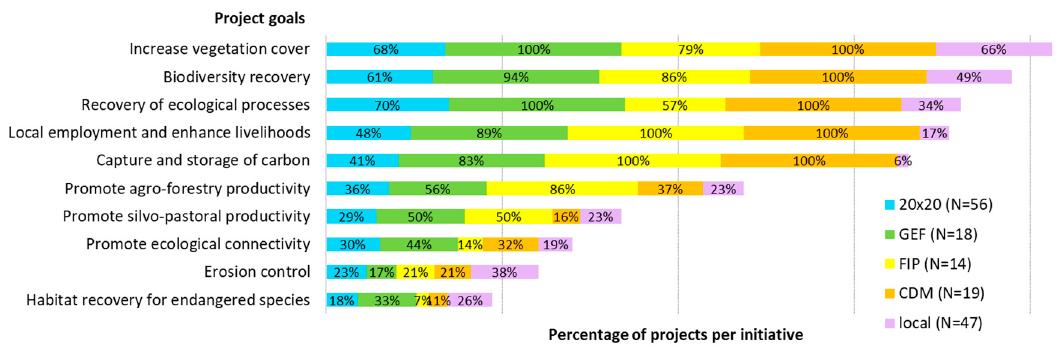
Figure 2. Overview of project goals. The 10 goals (out of 16) that occurred most are presented. The bars in the figure indicate the percentage of projects per restoration initiative that have a particular goal in their restoration strategy. One restoration project can have multiple goals. The total number of projects analysed was 154. Note: an earlier version of this figure was previously published as Figure 15.3 in Verchot et al. [41].